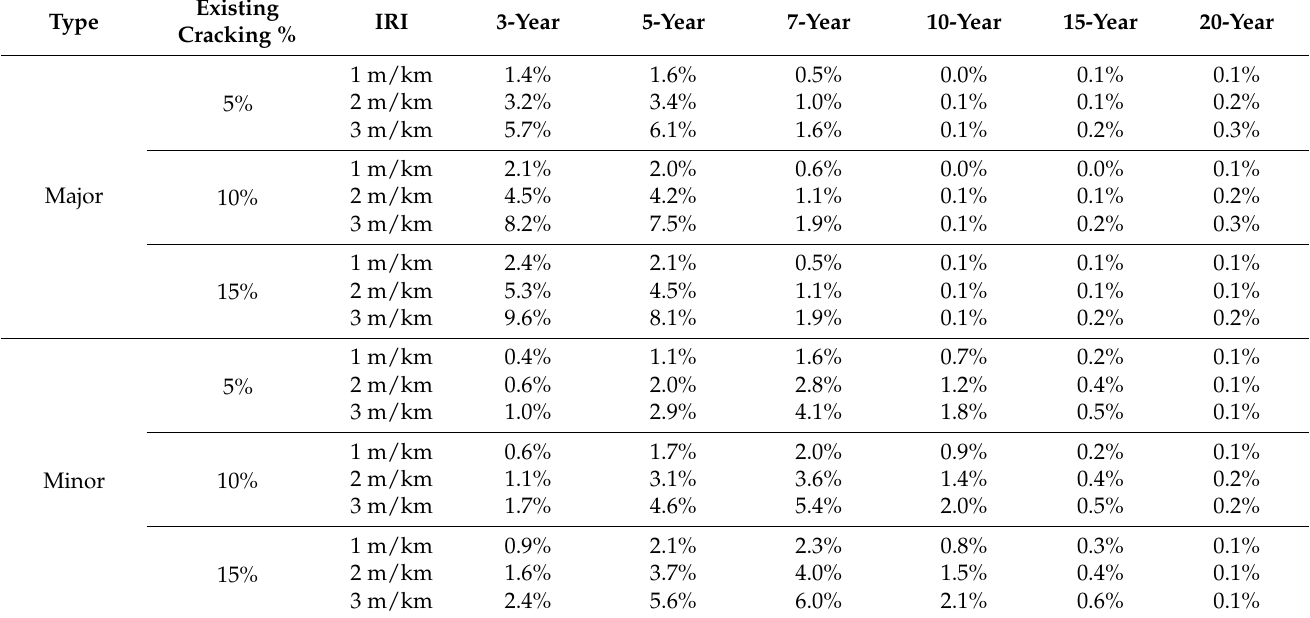
Table 3. Effect of existing cracking on increasing ratio of reflective fatigue cracking due to dy- namic